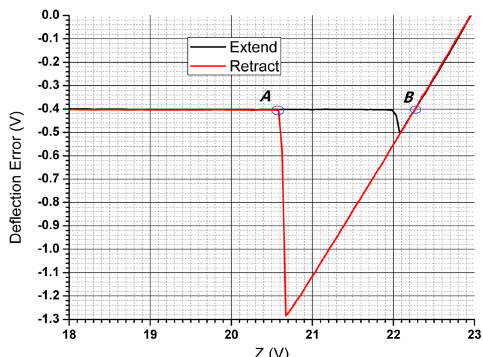
Figure 9. Typical data of deflection Error vs Z displacement curve obtained in adhesion force test.